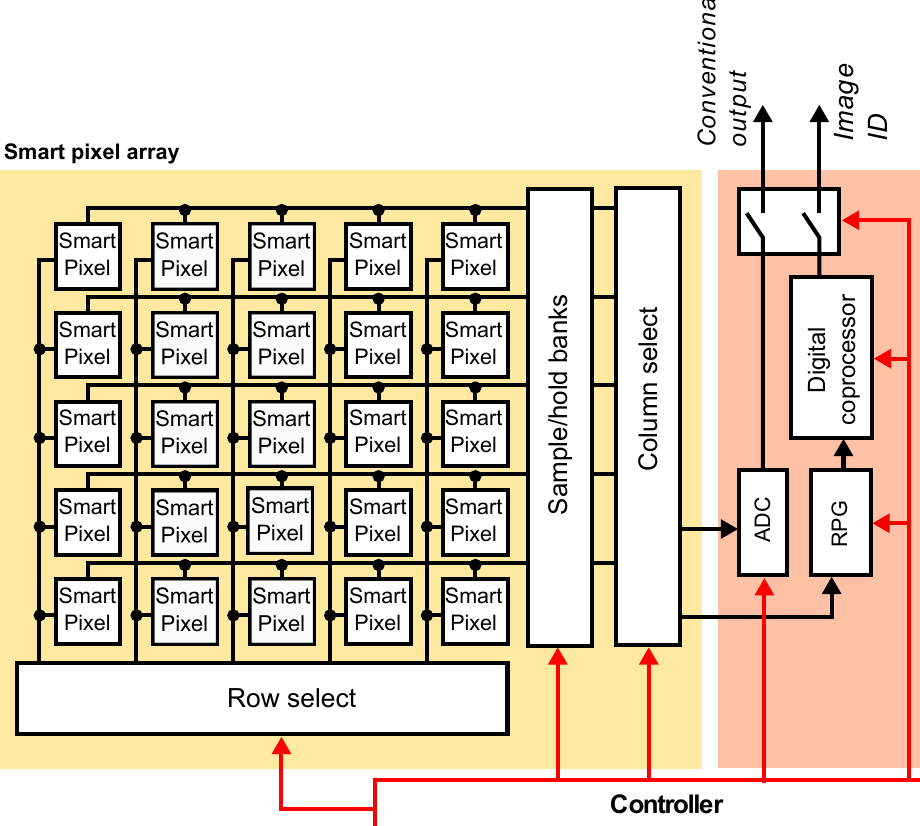
Figure 4. Architecture of the proposed SIS. An array of smart pixels outputs either the pixel value or the difference between horizontally adjacent pixels. An RLBP generator (RPG) reads pixel values and creates an 8-bit RLBP for each pixel in the image. The digital coprocessor computes histograms of RLBP patterns to construct the feature vector, executes the LDA projection on each vector, and selects the nearest neighbor from a stored set of projected vectors using the Euclidean